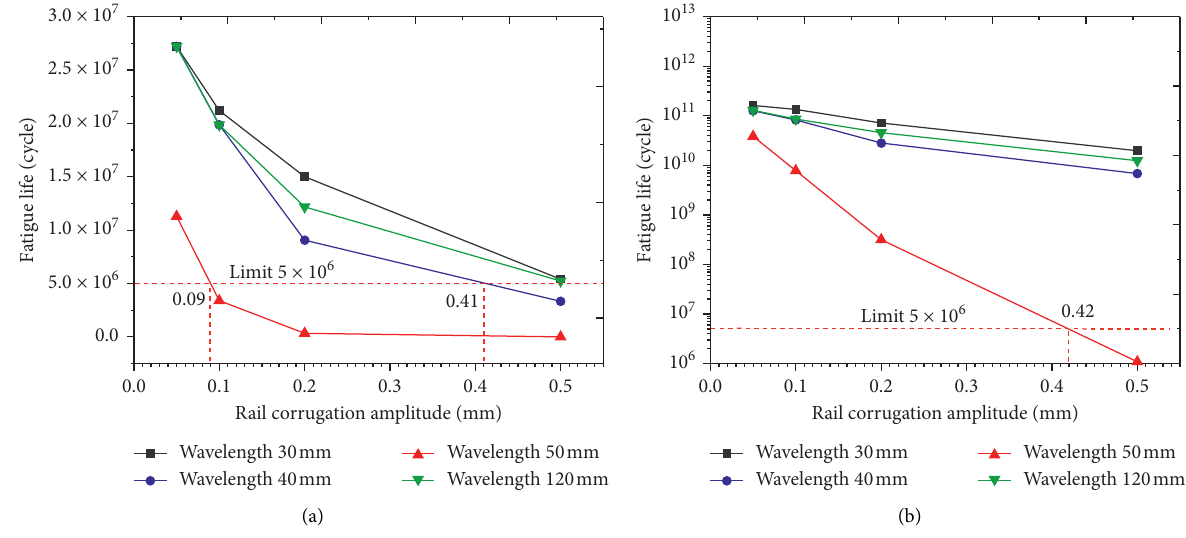
Figure 8: Fatigue lives of elastic rail clips under rail corrugation: (a) 38Si7; (b)